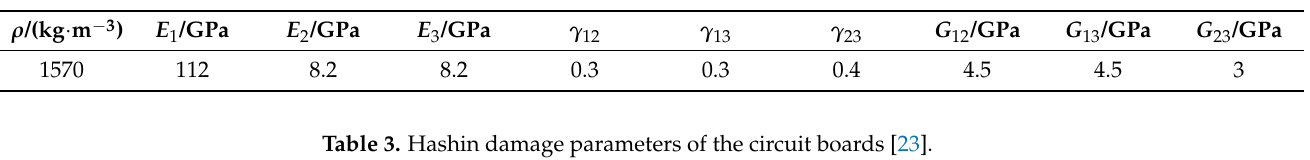
Table 2. Parameters of the orthotropic material model for the circuit boards [23].